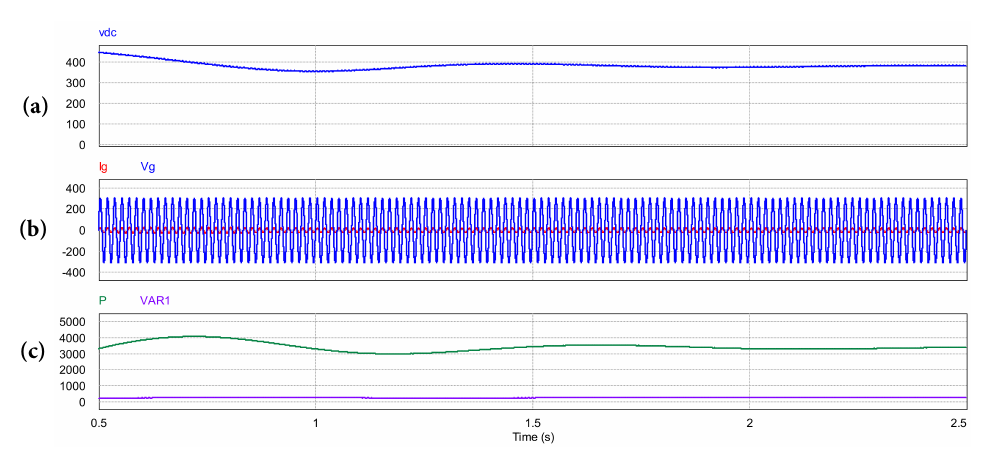
Figure 25. 3.3 kW DC-AC single phase full bridge converter, closed loop performing in inverter mode. ( a ) DC bus voltage, ( b ) grid current (red) and grid voltage (blue) , ( c ) active (green) and reactive (purple) power.